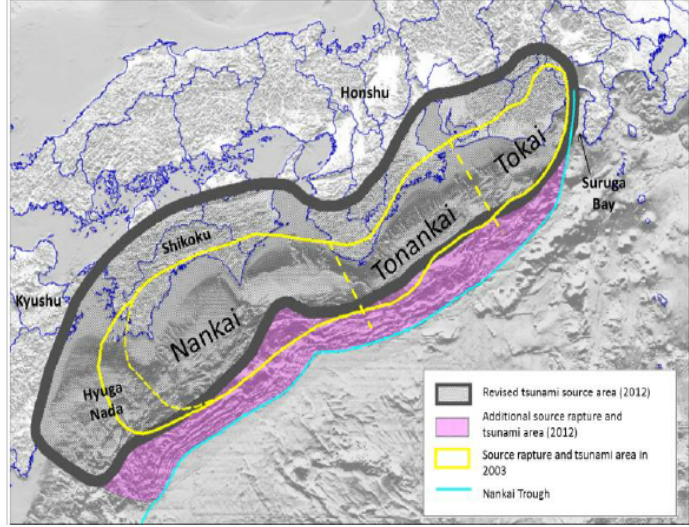
Figure 4. The expected initial disturbance area for an M9 earthquake, according to [1].